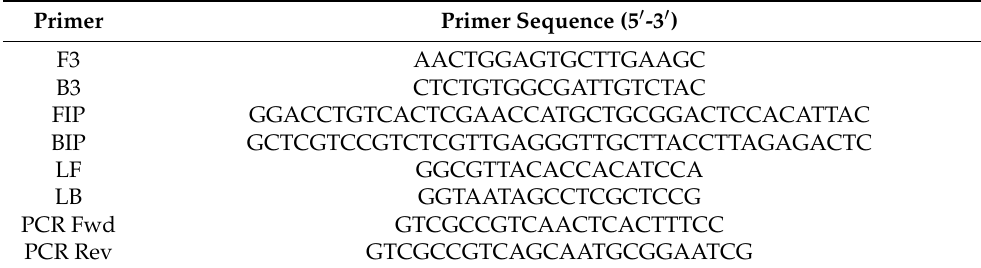
Figure 2. A schematic diagram of the LAMP primer design used in this experiment. Table 1. Sequences of LAMP and PCR primers involved in this study.